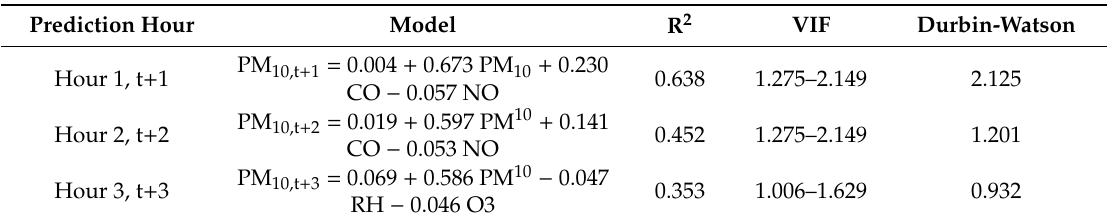
Table 4. Model summary for PM 10 concentration forecasting during transboundary haze events in